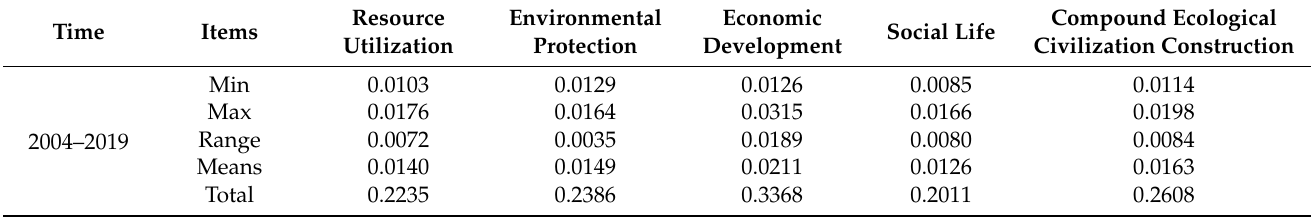
Table 3. Descriptive statistics of the ecological civilization construction index of Jiangsu